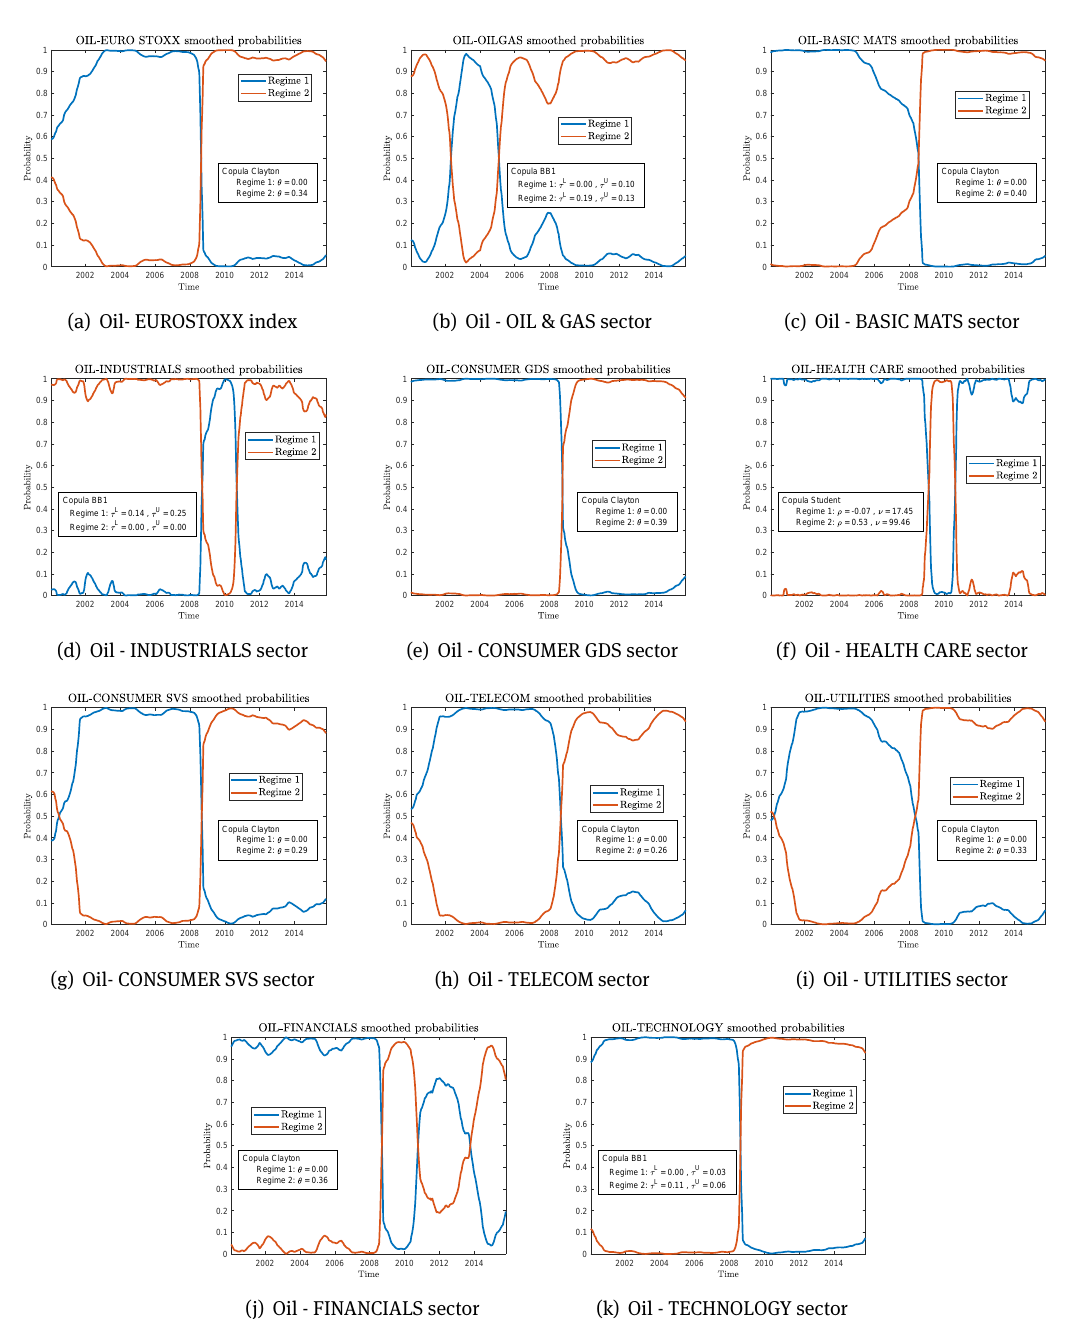
Figure 5a: Smoothed probabilities assuming same copula type but different copula parameter across regimes